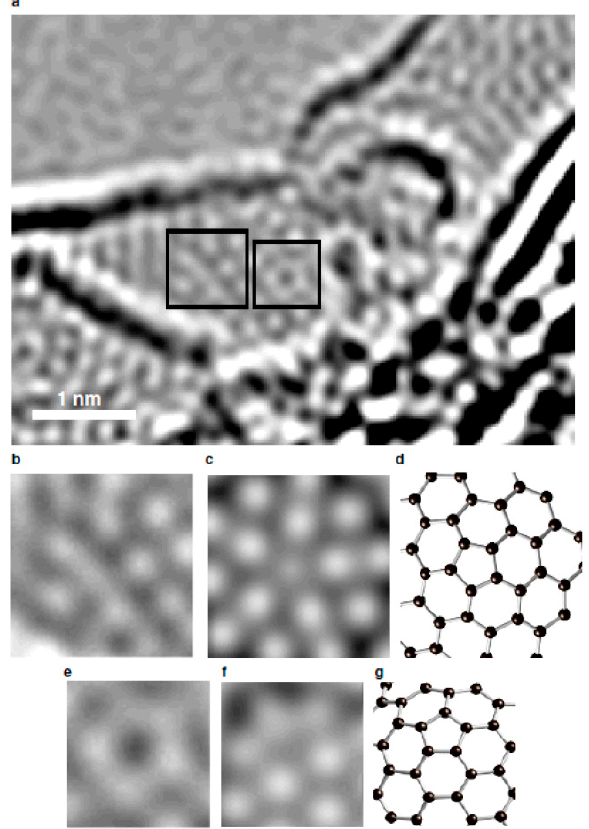
Figure 17. ( a ) Aberration-corrected micrograph of activated carbon heated to 2000 °C. ( b , e ) Enlarged regions showing pentagonal arrangement of spots. ( c , f ) Simulated images of structures shown in ( d , g ), respectively. Reproduced with permission from Harris et al. [81]. Copyright IOP Publishing, 2008.